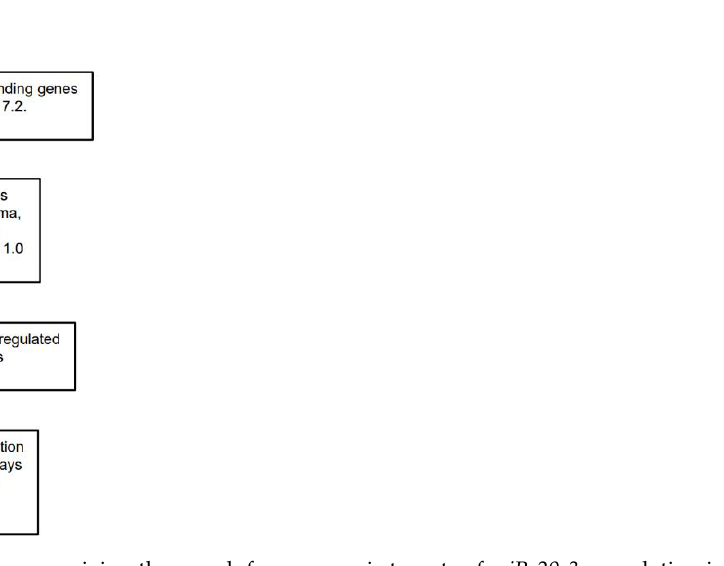
Figure 3. Flowchart summarizing the search for oncogenic targets of miR-29-3p regulation in ICC cells. To identify miR-29-3p target genes, we screened putative targets using the TargetScan database and TCGA database. A total of 888 targets were upregulated in cholangiocarcinoma tissues. These genes were then categorized into KEGG (Kyoto Encyclopedia of Genes and Genomes) pathways using the GeneCodis database. Finally, 20 pathways that were regulated by miR-29-3p were identified.